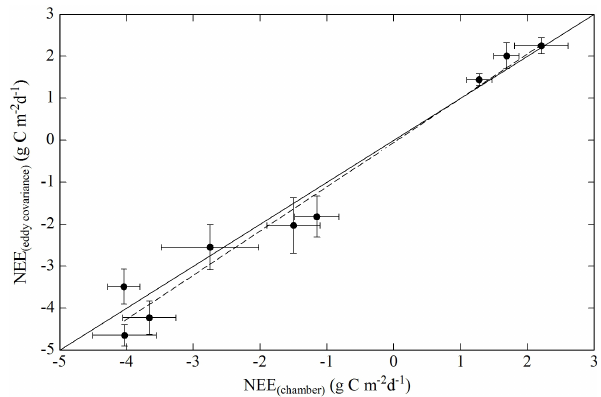
Fig. 1. Comparison between 7-day average daily integrated net ecosystem exchange of CO 2 (NEE; gCm − 2 s − 1 ) derived from chamber and eddy covariance data at the valley bottom meadow. The solid line is the 1:1 line, the dotted line corresponds to a lin- ear regression (NEE ( eddy covariance ) = 1.05 NEE ( chamber ) − 0.05; R 2 =0.97). Error bars represent standard errors and reflect temporal variability in gap-filled NEE (eddy covariance) and in meteorologi- cal input parameters of light response curve models (Eq. 2), which were used to simulate NEE based on chamber